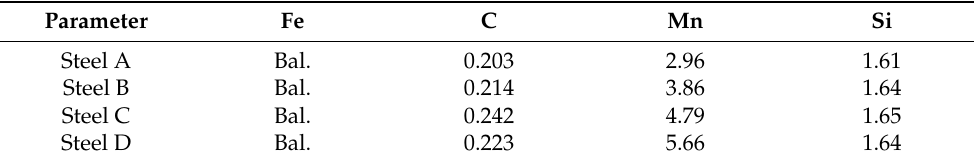
Table 1. Composition of the samples in the data set (wt.%).